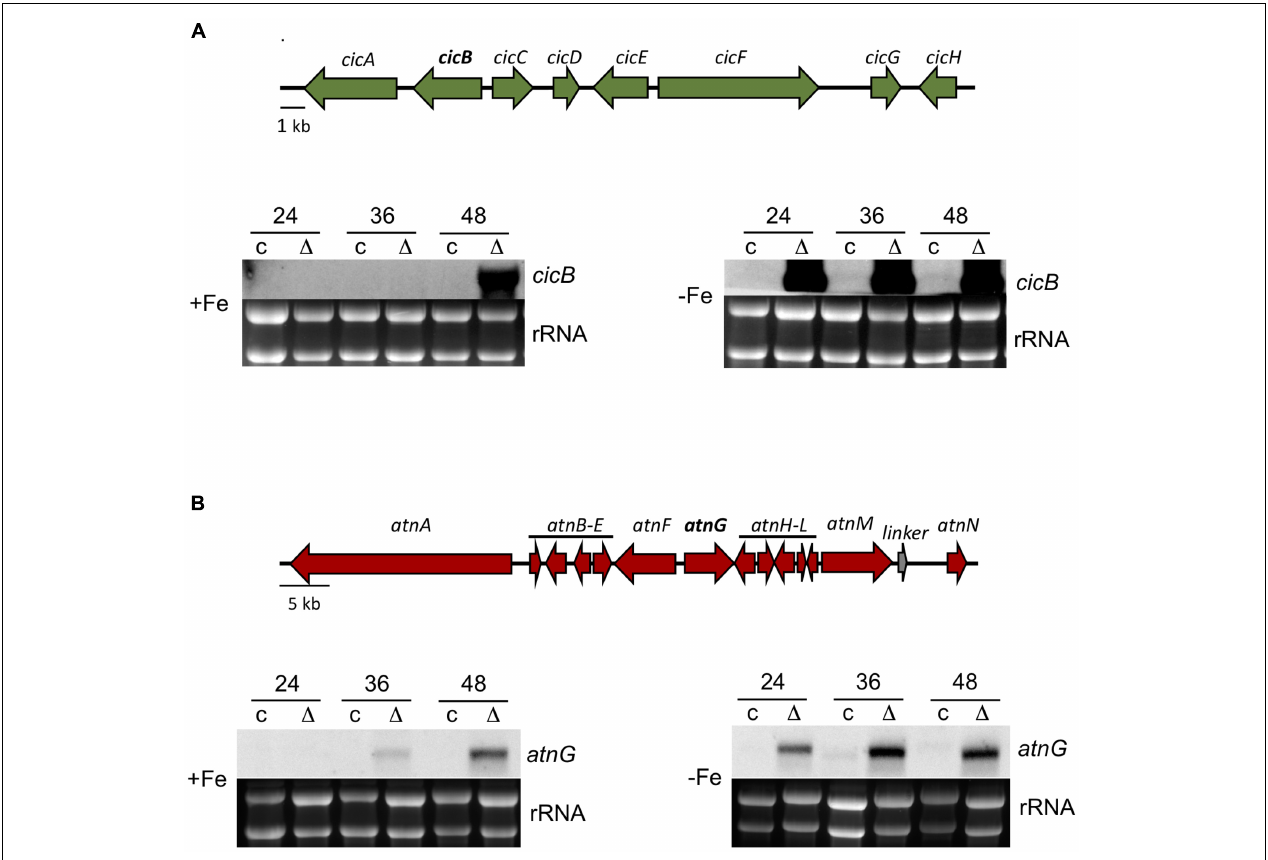
FIGURE 6 | Expression analysis of members of the cichorine and aspercryptin biosynthetic gene cluster in hosA knock out mutants compared to hosA -complemented strains. A schematic representation of cluster genes of the cichorine- ( cicA-H ) and the aspercryptin- ( atnA-N ) gene cluster is shown on the top of the figure. For expression analysis, hosA mutants and complemented strains were grown for 24, 36, and 48 h at 37 ◦ C in GMM with (-Fe) or without (+Fe) iron starvation. Blotted RNA was hybridized with digoxigenin-labeled probes for the cichorine cluster gene cicB (A) and the aspercryptin cluster gene atnG (B) . Ethidium-stained rRNA was used as quality and loading